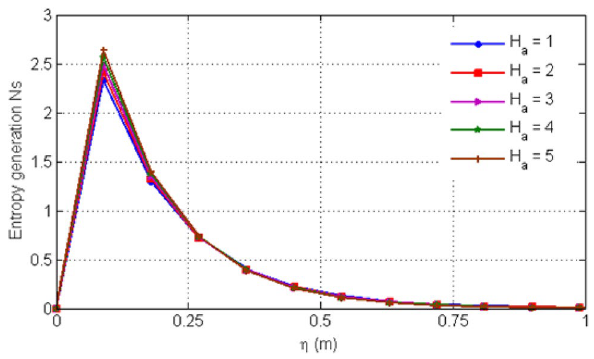
Figure 11. Variation in entropy generation for diverse values of Ha.